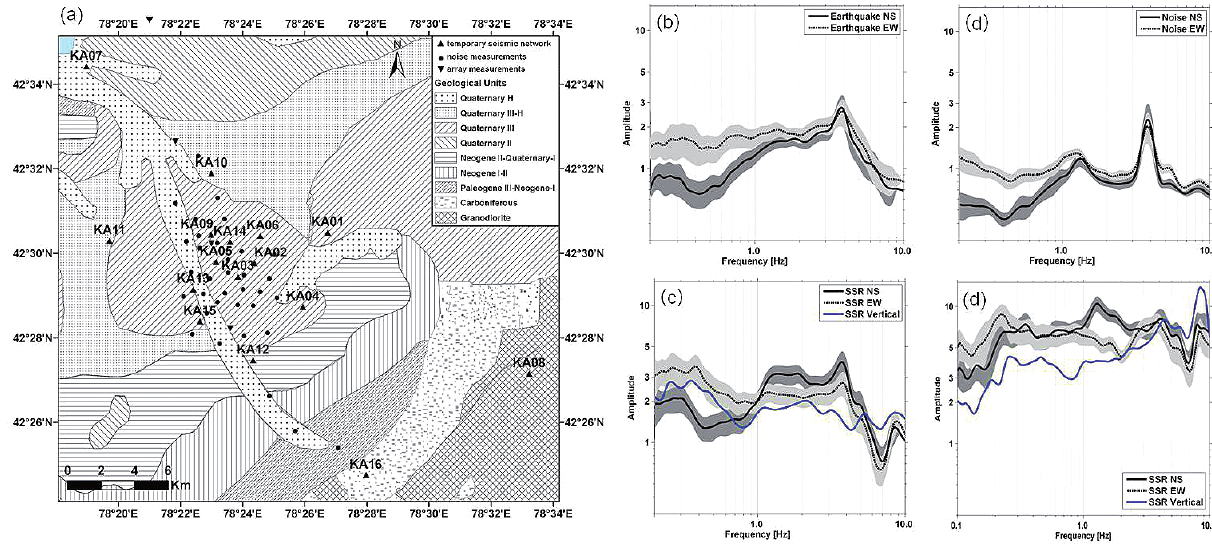
Figure 3. (a) Surface soil material for the city of Karakol. Seismic noise measurement sites (black dots) and installation sites of the tempo- rary seismic network (black triangles) are indicated. (b) Horizontal-to-vertical spectral ratio plus/minus one standard deviation for earth- quakes for station KA02. (c) H/V spectral ratio for noise at station KA02. (d) SSR for earthquakes for KA02 using KA08 located on bedrock as a reference. (d) SSR for earthquakes for KA07 using KA08 as a